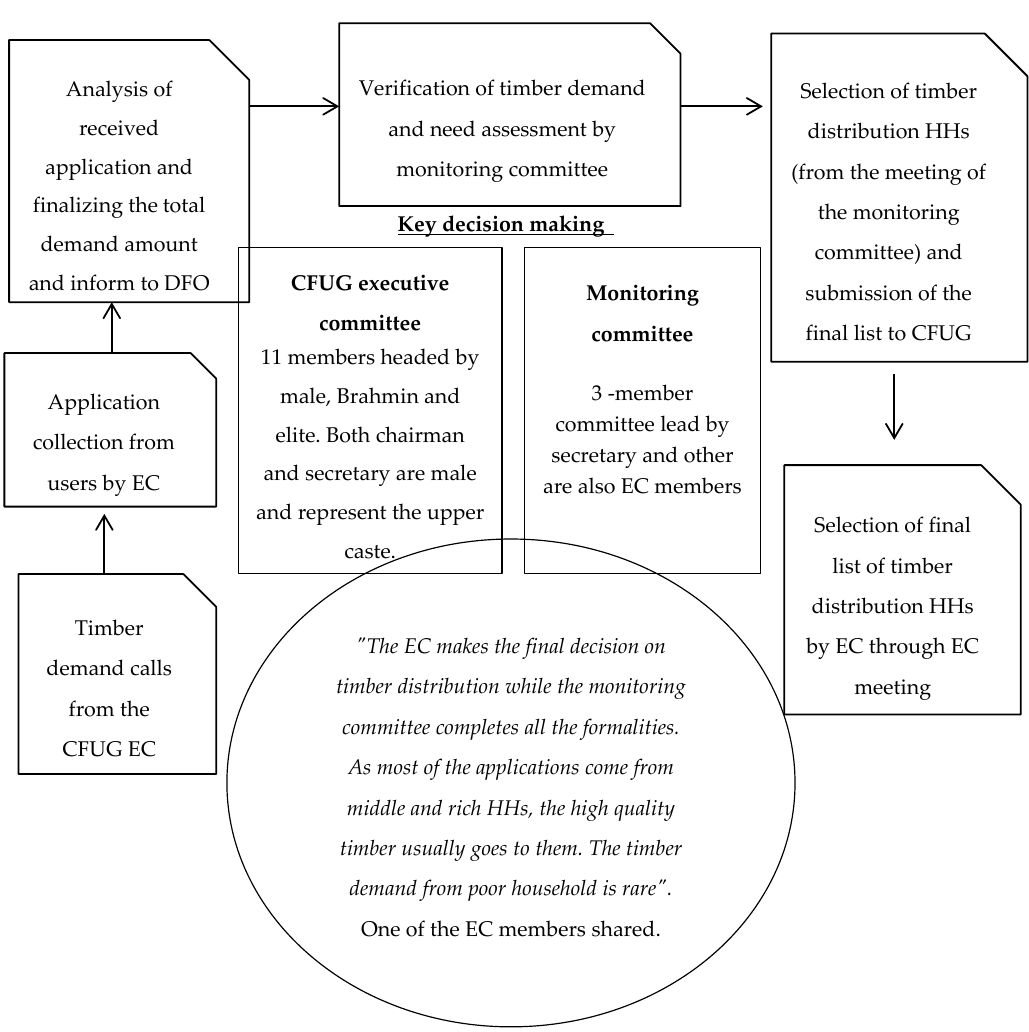
Figure 3. Timber distribution decision-making process at the CFUG level.